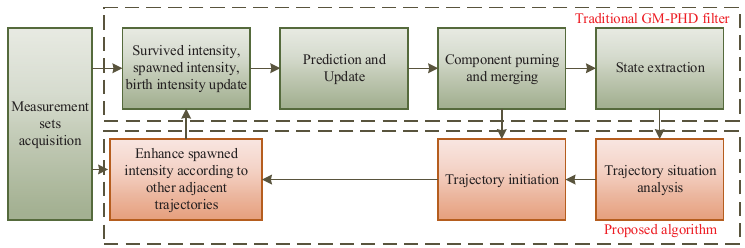
Figure 3. GM-PHD filter based on trajectory situation feedback